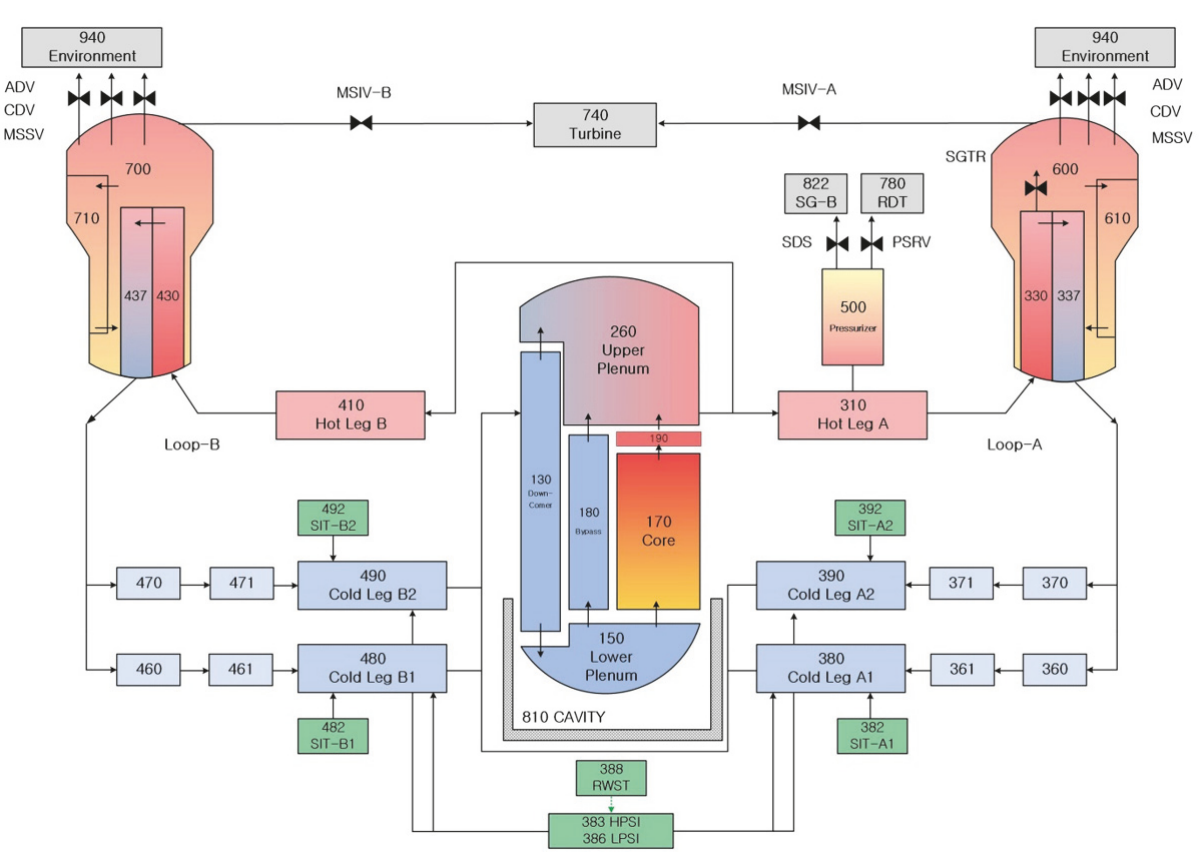
Figure 1: MELCOR nodalization of